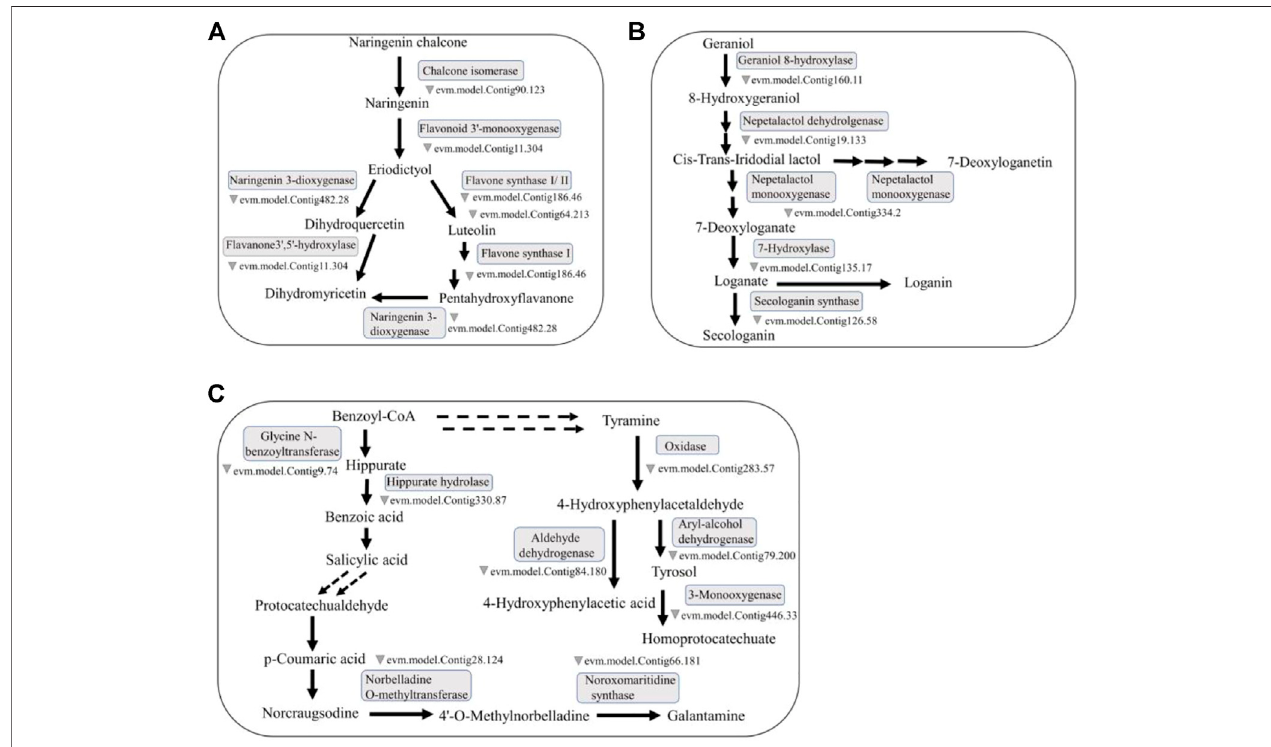
FIGURE 2 | Representative medicinal compounds in O. fragrans and their biosynthetic pathways. (A) The main synthesis pathway containing naringenin, luteolin and DHQ in the fl avonoid biosynthesis pathway is presented. Naringenin can produce luteolin and DHQ through reactions catalysed by different enzymes. (B) Loganic acid is a terpenoid. The synthetic pathway of loganic acid in the monoterpene biosynthesis pathway. Loganic acid can be produced from geraniol through reactions catalysed byaseriesofenzymes. (C) SA,PCA andTyaresynthesizedviathree differentphenolicacidbiosynthesispathways, but thesyntheticpathway ofSAcan be connected to the synthetic pathways of PCA and Ty. The double dotted arrow in the fi gure represents the connection between the pathways. (The relevant O. fragrans gene information in this biosynthetic pathway map comes from an article about O. fragrans published by) (Yang, et al., 2018).